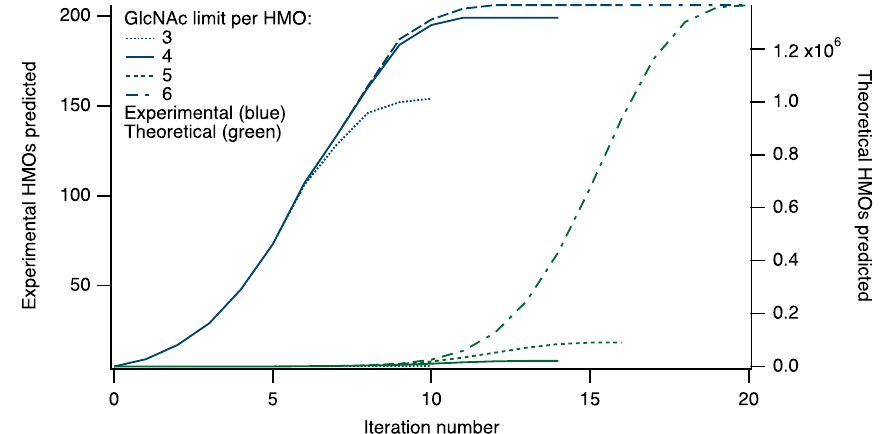
Figure 3. Growth of HMOs predicted by the simulator. Numbers of experimental (left axis) and theoretical (right axis) HMOs predicted, with increasing iteration number, for simulations limited to between 3 and 6 GlcNAc residues per oligosaccharide. At the final point on each curve, reaction networks were closed, with no further structures being added at higher iteration